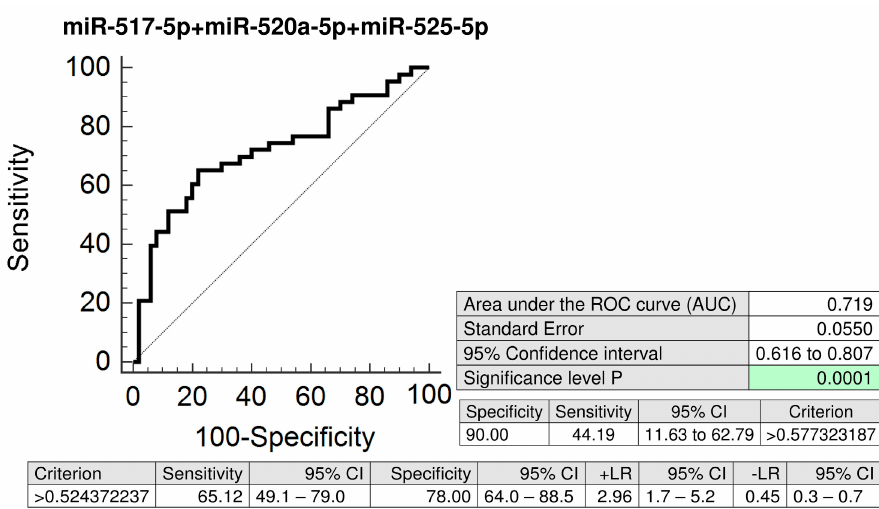
Figure 5. ROC curves—the best combination of C19MC microRNA biomarkers—evaluation of the potential of the first trimester C19MC microRNA screening in plasma exosomes to predict subsequent onset of PE. The combination of miR-517-5p, miR-520a-5p, and miR-525-5p showed the best predictive performance for the prediction of the later occurrence of PE (44.19% sensitivity at 10.0% FPR). PE: preeclampsia.